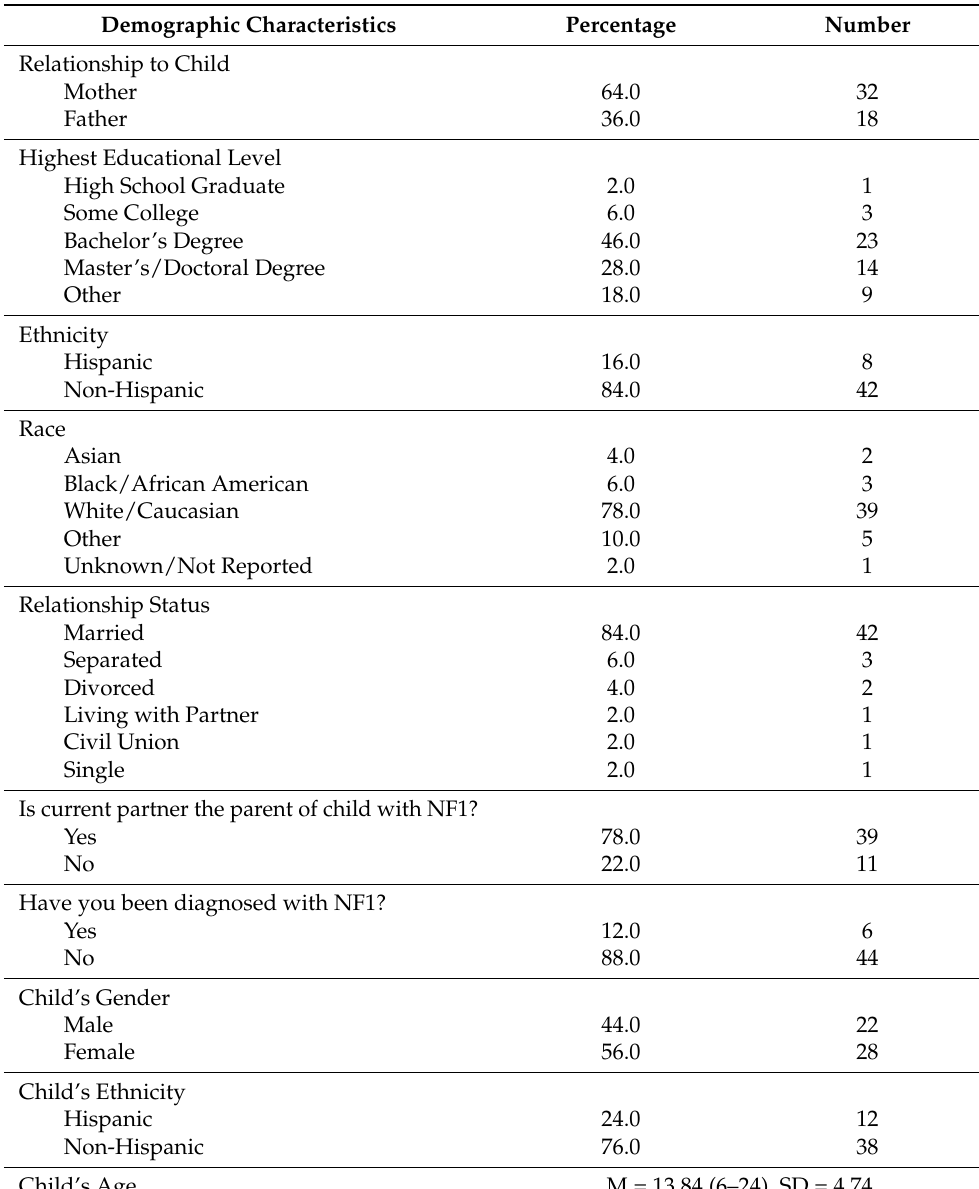
Table 1. Demographic Characteristics of